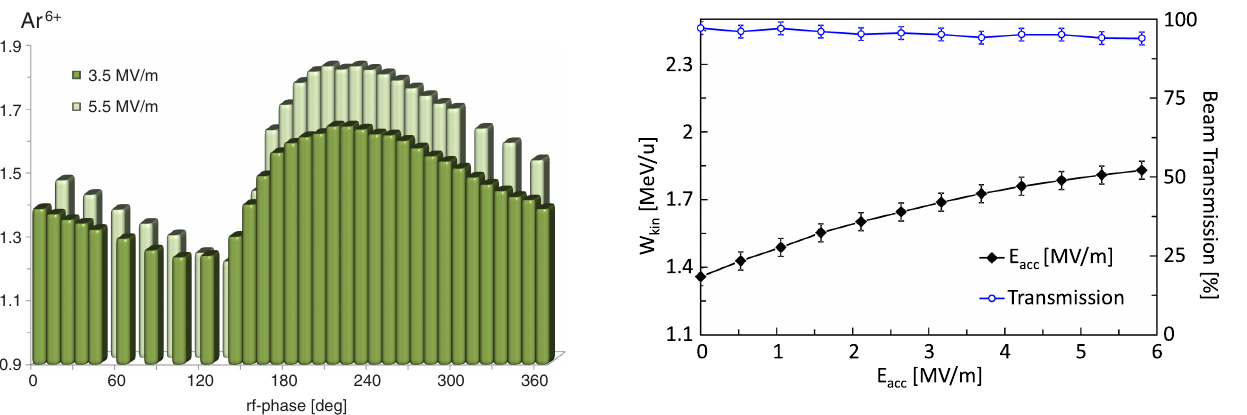
FIG. 16. Amplitude scan of Ar 6 þ -rf phase of 210°.